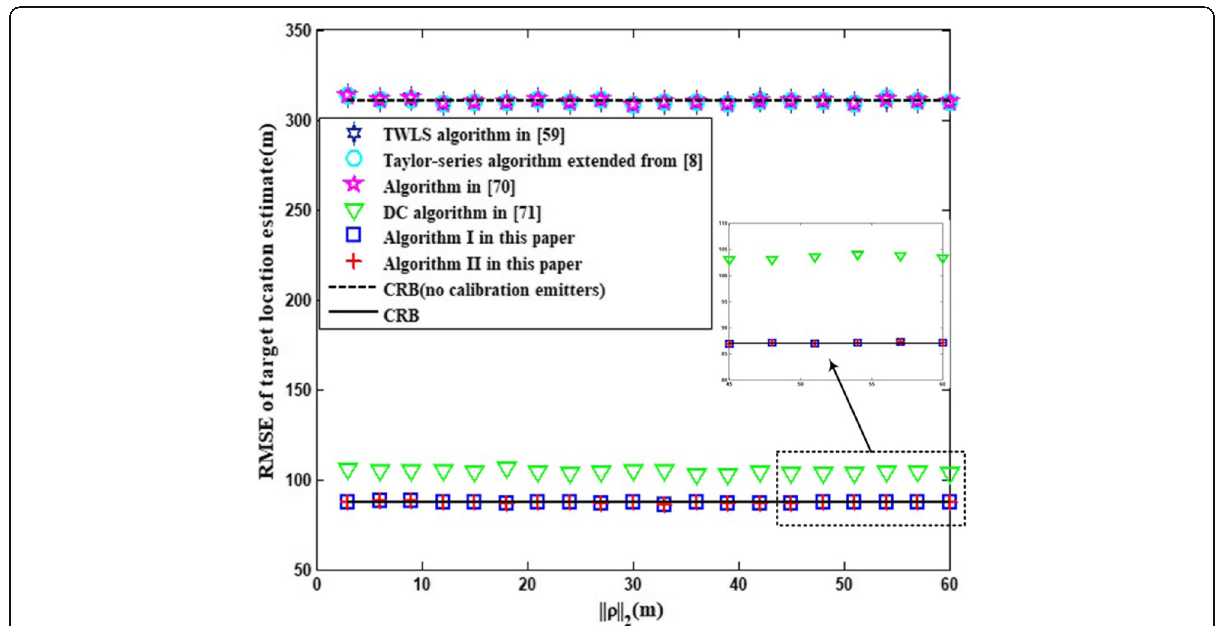
Fig. 12 RMSE of target location estimate versus ‖ ρ ‖